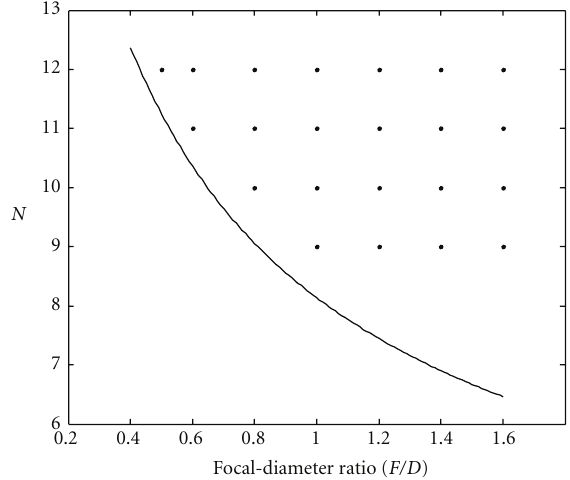
Figure 2: The dependence of the number of facet rows N on mini- mum F/D ratio with the allowable RMS deviation δ rms = 0 . 36